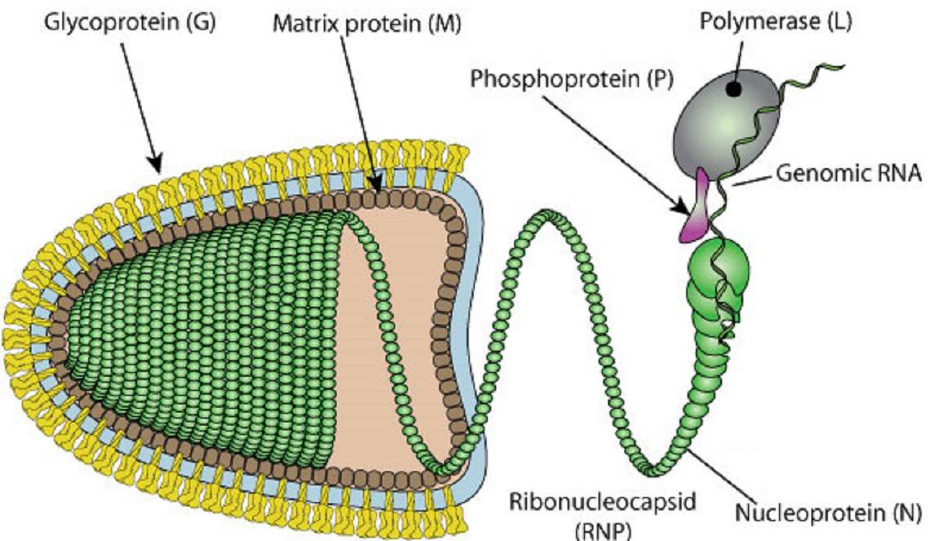
Figure 1. Structural features of RABV. In mature RABV, the nucleoprotein, phosphoprotein, and viral polymerase envelop the genomic RNA in a structure known as the ribonucleocapsid (RNP). The matrix protein surrounds the RNP and determines the shape of the virus. The matrix protein also anchors the glycoprotein to the envelope [10] (original source of the image: Philippe Le Mercier, SIB Swiss Institute of Bioinformatics).